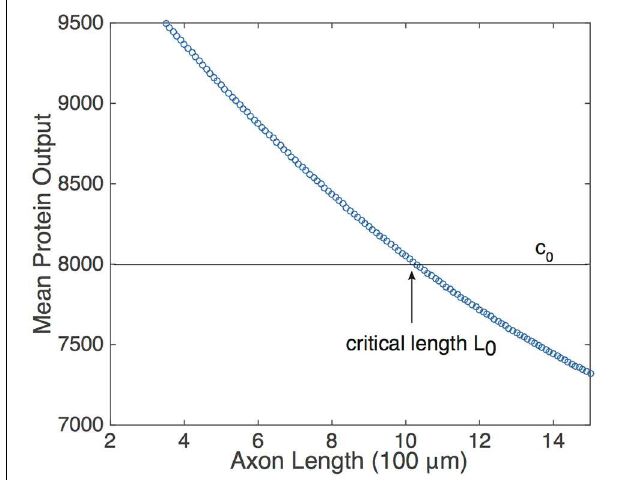
FIGURE 4 | Relationship of the mean protein output ¯ c and axonal length L , obtained by time averaging the solution to Equation (5) for several values of τ . Function definitions and parameter values are as in Figures 2 , 4 . The existence of a threshold protein output c 0 could provide a mechanism for determining a critical length L 0 .